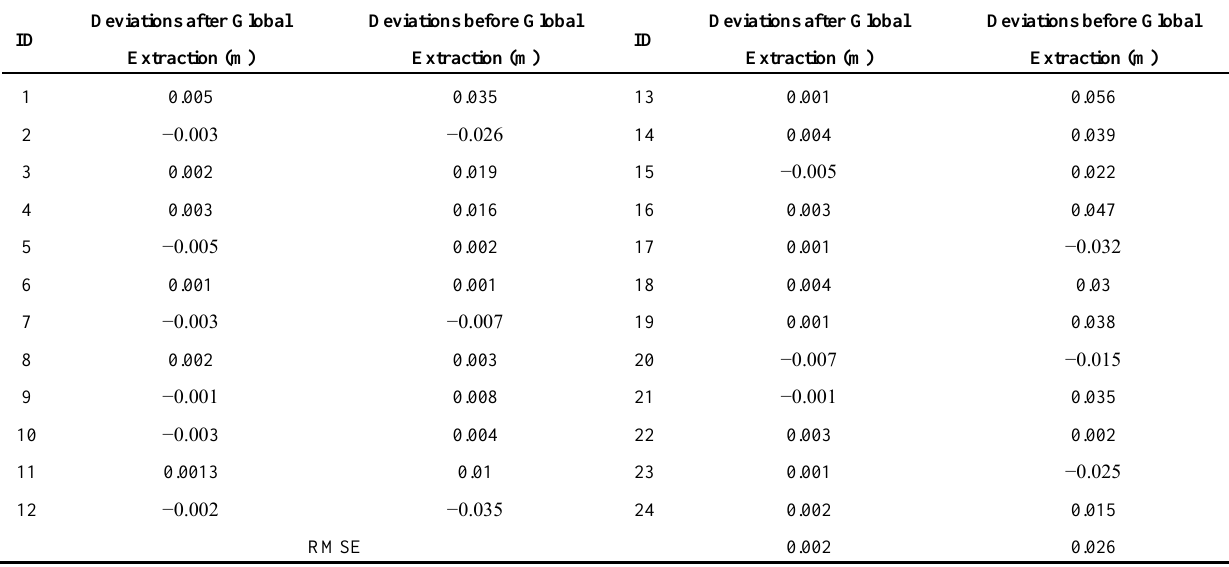
Table 2. Comparison of the fitting accuracies.